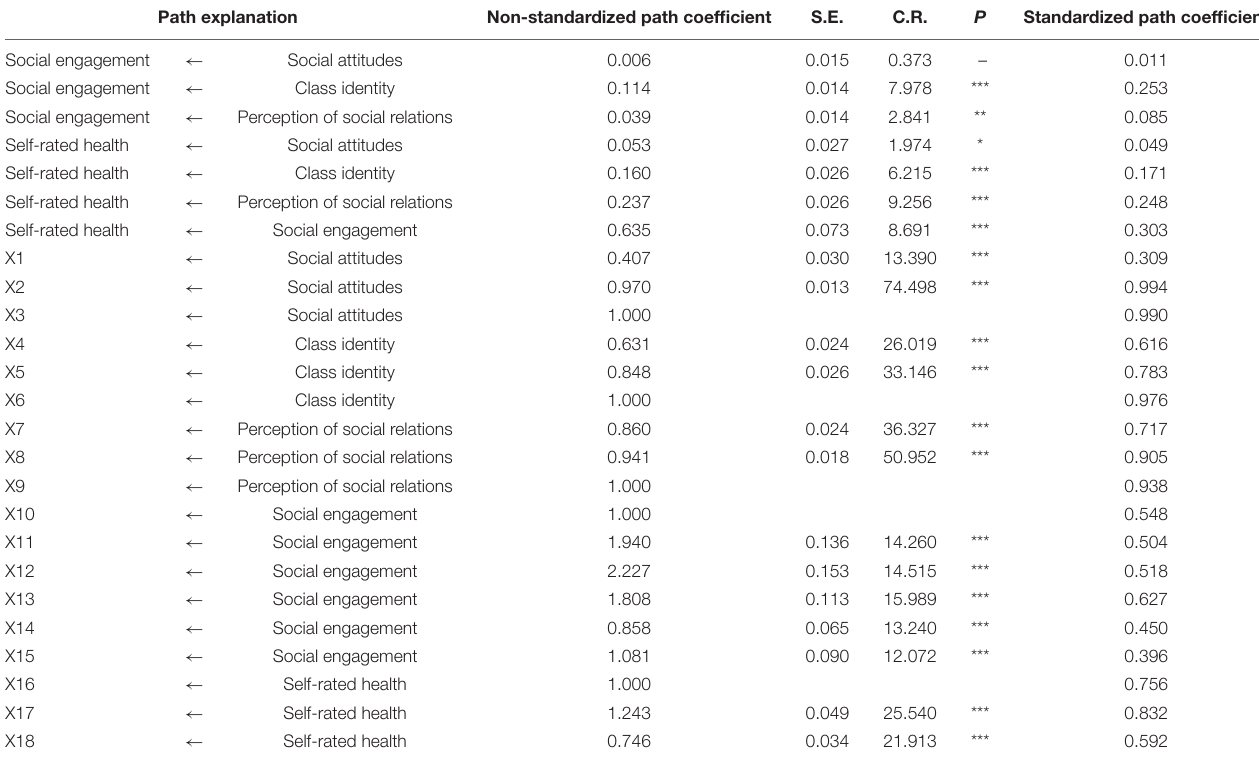
TABLE 4 | Estimation results for the path coefficients. Path explanation